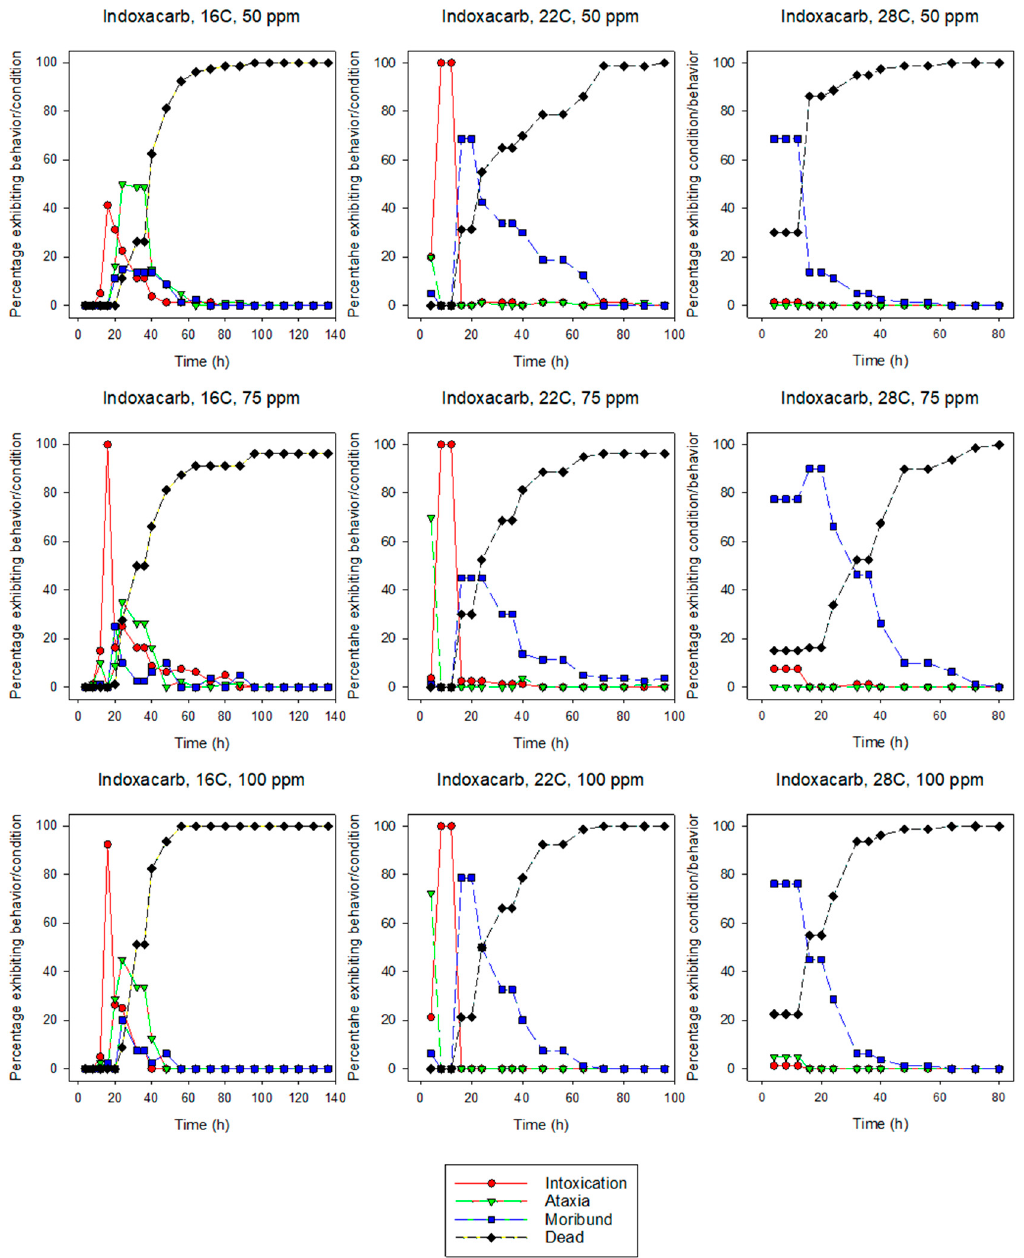
Figure 3. Effects of concentration and temperature on the behaviors of indoxacarb-exposed eastern subterranean termites, R. flavipes .